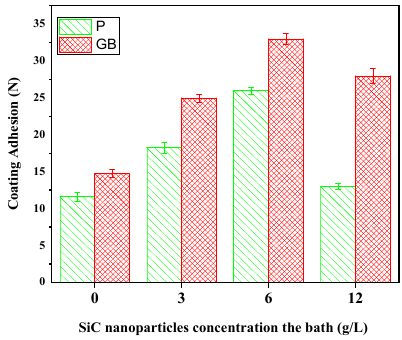
Figure 14. The analysis of critical load of the Ni-W and Ni-W/SiC composite coatings on 45 steel substrates subjected to the grit-blasting pretreatment by varying the SiC concentration in the electrolyte.